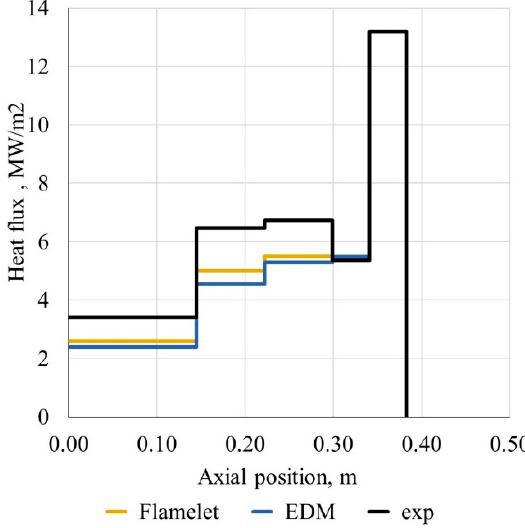
Figure 7. Segment averaged heat flux density distribution.